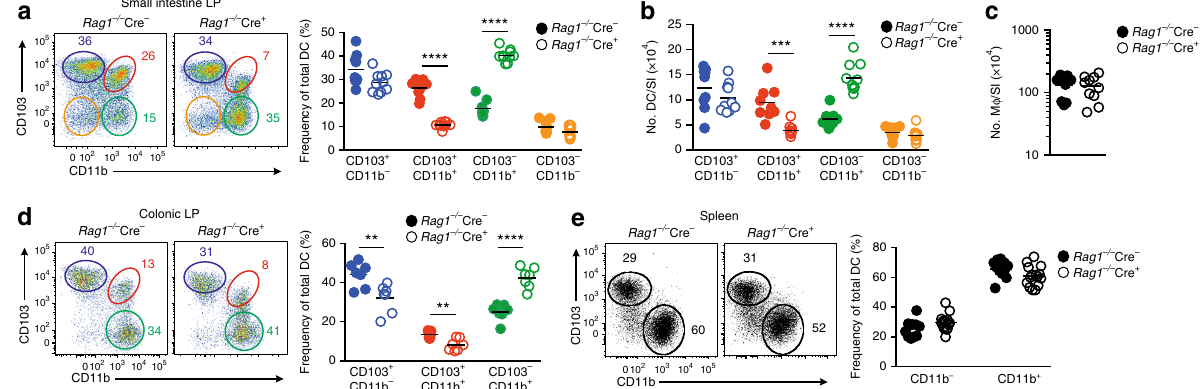
Fig. 3 TGF β R1 signalling controls dendritic cell homeostasis in the intestine. a Expression of CD103 and CD11b by live CD45 + CD11c + MHCII + CD64 − DC ( left ) and relative frequencies of DC subsets ( right ) in the SILP of Rag1 − / − Tgfbr1 fl / fl mice ( Rag1 − / − Cre − ) or Rag1 − / − CD11c-Cre. Tgfbr1 fl / fl ( Rag1 − / − Cre + ) mice. b Absolute numbers of DC subsets and c CD64 + Ly6C − macrophages from SI from mice in a . Data are pooled from three independent experiments with 9 ( Rag1 − / − Cre − ) or 10 ( Rag1 − / − Cre + ) mice per group. d Expression of CD103 and CD11b by live CD45 + CD11c + MHCII + CD64 − DC ( left ) and relative frequencies of DC subsets ( right ) in the colonic LP of Rag1 − / − Cre − or Rag1 − / − Cre + mice. Data are pooled from two independent experiments with a total of seven mice per group. e Expression of CD103 and CD11b by live CD11c + MHCII + DC ( left ) and relative frequencies of DC subsets ( right ) in the spleen of Rag1 − / − Cre − or Rag1 − / − Cre + mice. Data are pooled from four independent experiments with 11 ( Rag1 − / − Cre − ) or 15 ( Rag1 − / − Cre + ) mice/group. * p < 0.05,